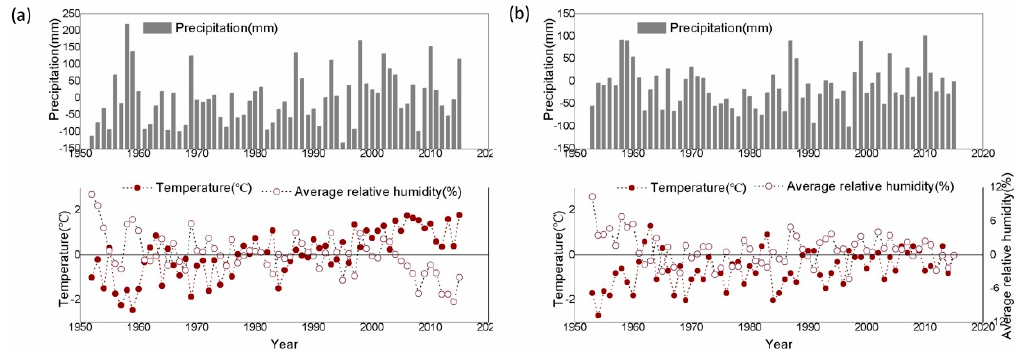
Figure 2. Long-term trend of mean annual climate data (temperature, precipitation, average relative humidity) of ( a ) Manas River Basin in the middle of the Northern Tianshan Mountain; ( b ) Ili River Basin in the west of the Northern Tianshan Mountain. Bars indicate annual precipitation anomaly (in mm), and curves with red color represent annual temperature anomaly (in °C), dashed lines with a hollow circle represent trends in annual average relative humidity anomaly (in %).